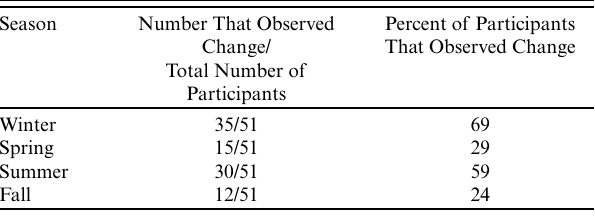
Table 2 . Intergenerational observations of change by season.